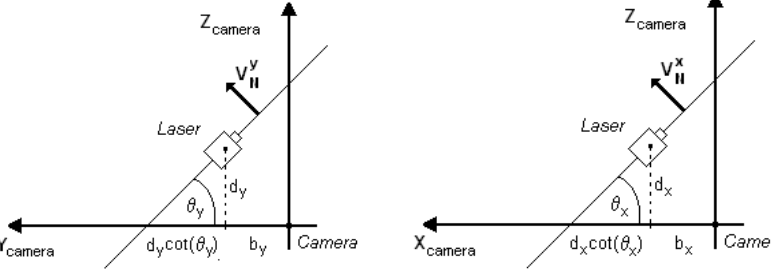
Figure 9. Generated light planes and the geometric